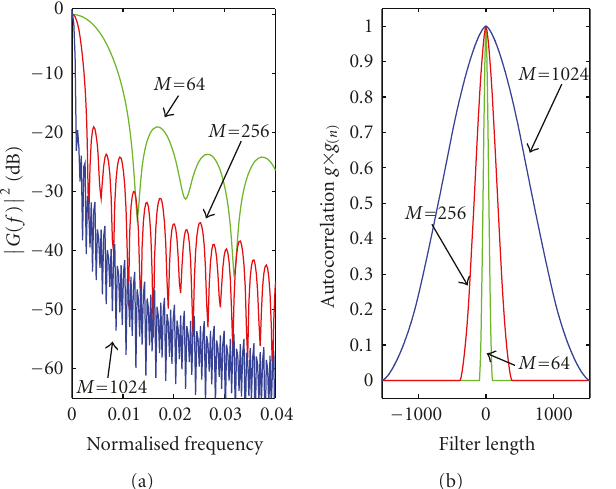
Figure 8: Frequency response and pulse autocorrelation for parameters M 0 = 2, N 0 = 3, and L f = N .